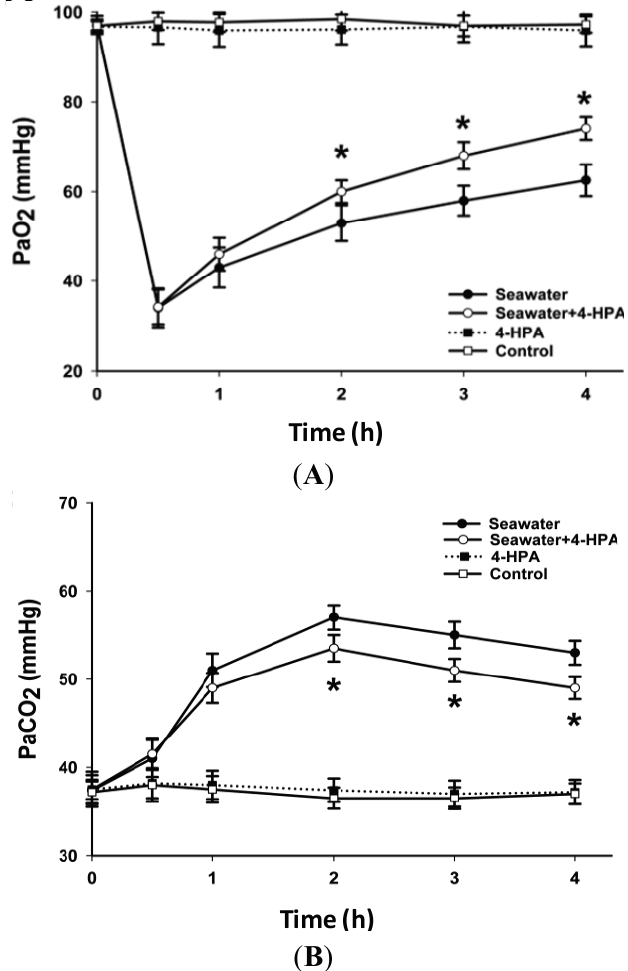
Figure 2. Effects of 4-HPA on PaO 1, 2, 3, and 4 h after seawater instillation with or without 4-HPA treatment, blood samples were obtained from left carotid artery and then PaO by blood gas analyzer. Data are means ± standard deviation (SD) ( n = 10), * p < 0.05 vs. seawater